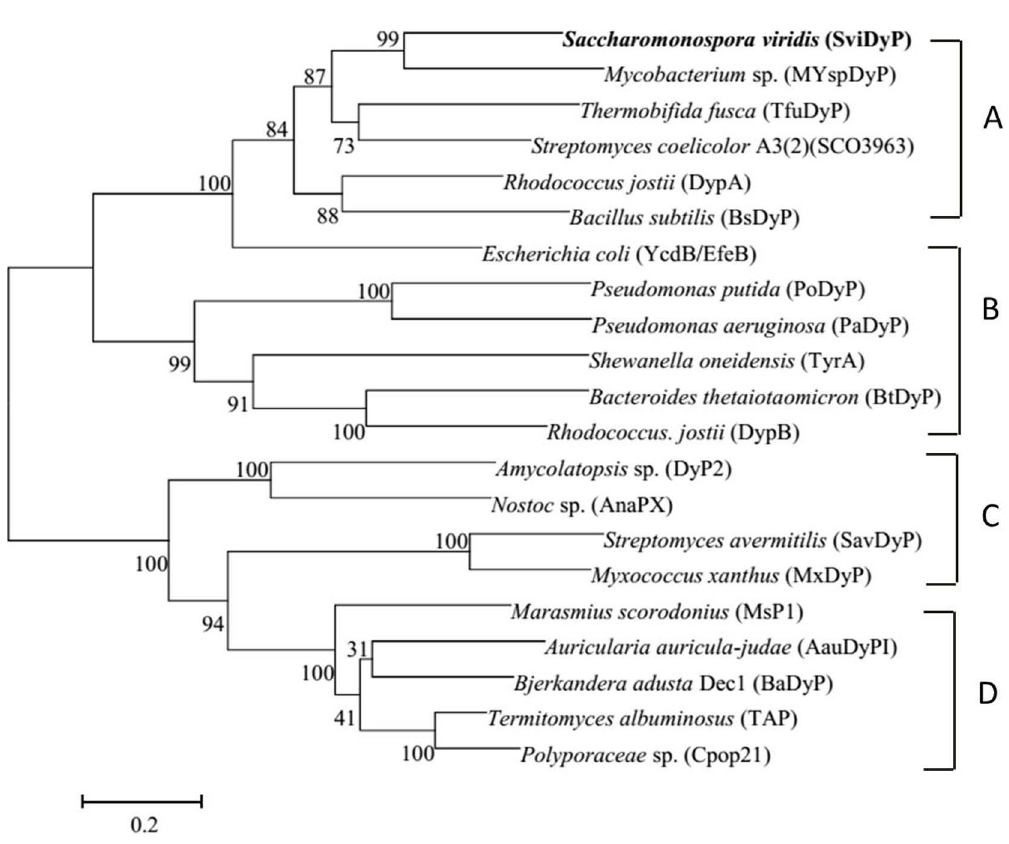
Figure 2. Phylogenetic tree analysis. Phylogenetic tree showing the relationship between Svi DyP and other isolated DyPs belonging to subfamilies A–D: MYspDyP from Mycobacterium sp. (GI: 126434170), Tfu DyP from Thermobifida fusca (GI: 71917209), Sco3963 from Streptomyces coelicolor A3(2) (GI: 541881521), DypA from Rhodococcus jostii (GI: 499917154), Bs DyP from Bacillus subtilis (GI: 732344), EfeB/YcdB from Escherichia coli (GI: 2506638), Po DyP from Pseudomonas putida (GI: 501229266), Pa DyP from Pseudomonas aeruginosa (GI: 94829180), TyrA from Shewanella oneidensis (GI: 119390160), Bt DyP from Bacteroides thetaiotaomicron (GI: 109158102), DypB from R. jostii (GI: 330689635), DyP2 from Amycolatopsis sp. (GI: 409973917), AnaPX from Nostoc sp. (GI: 75704119), Sav DyP from Streptomyces avermitilis (GI: 29604188), Mx DyP from Myxococcus xanthus (GI: 108465542), Msp1 from Marasmius scorodonius (GI: 261266601), Aau DyPI from Auricularia auricula-judae (GI: 433286646), TAP from Termitomyces albuminosus (GI: 20386144), and Cpop21 from Polyporaceae sp. (GI: 2160705). Confidence was evaluated with 1000 bootstrap replicates (values are indicated at branch points).